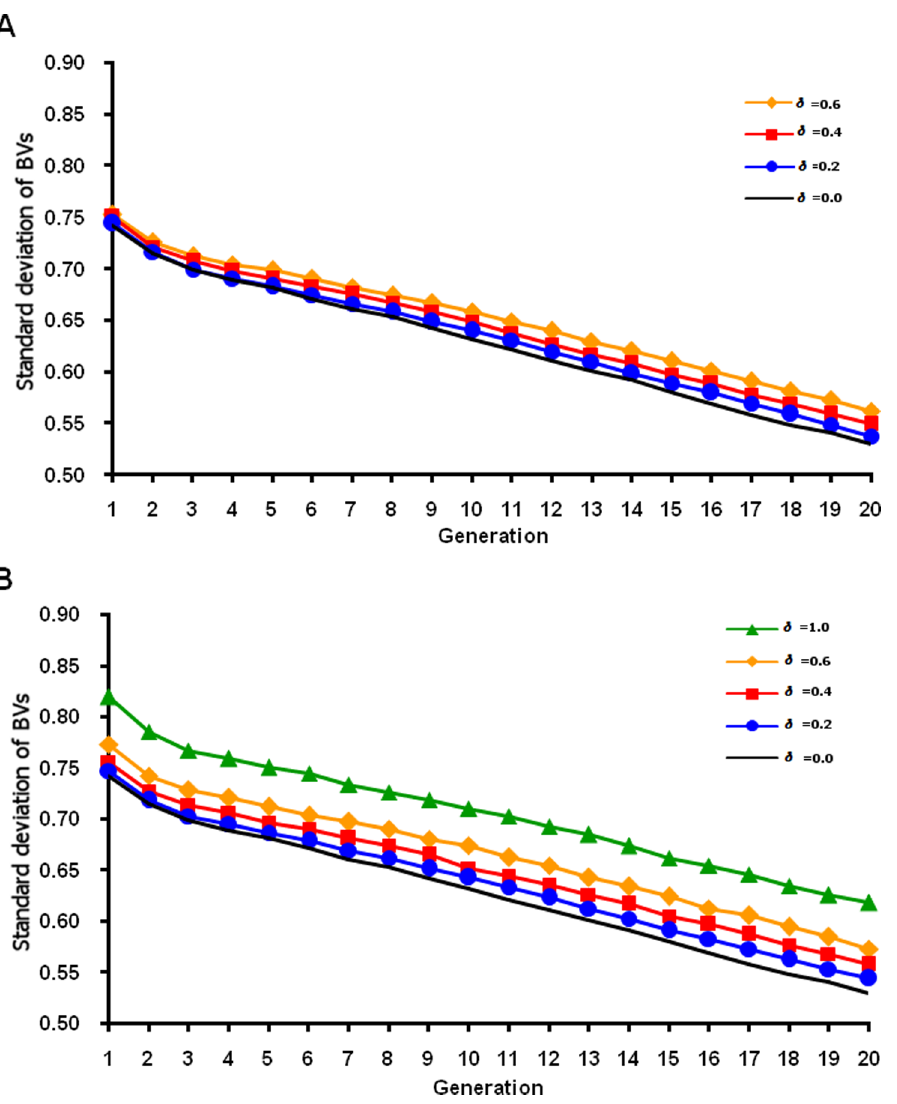
Figure 6. Standard deviation of true breeding value by generation based on a heavy-tailed QTL distribution. True breeding values (BVs) for a simulated population were based on unweighted ( d =0) or weighted (various d ) genomic selection and calculated using on true marker effects. Linear (A) and nonlinear (B) formulas were used to weight allele frequency.